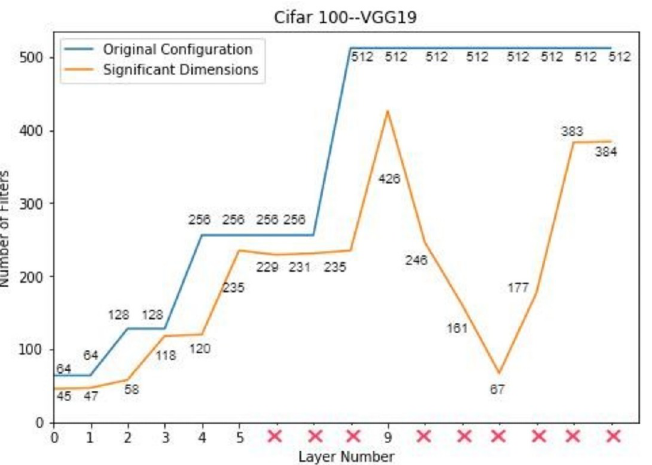
Fig 6. Compressed architecture of VGG-19 on CIFAR